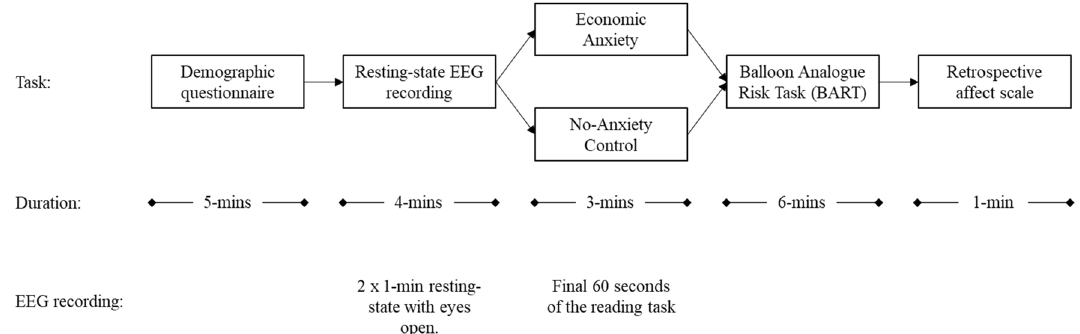
Figure 4. Flow chart of experimental procedure, duration of each task, and position of EEG doing well in the computerized Balloon Analogue Risk Task (BART 30 ). Participants pumped balloons across 20 trials, one balloon per trial, where each balloon had a variable and unknown pop-threshold. The average pop- threshold across trials was 15 pumps. Each pump slightly inflated the balloon and earned points but also brought the balloon closer to the pop-threshold. Popped balloons earned no points and participants could stop pumping at any time and collect the points earned on that trial. As in prior research using the BART, our primary measure of risk-taking was the average number of pumps on trials without explosions. We computed a second measure to tease apart strategic behavior and risk-taking—i.e., a coefficient of variability (COV). COV is computed here as the standard deviation across trials divided by average pumps across trials. Lower degrees of variability (i.e., lower COV scores) is thought to reflect more stringent adherence to a behavioral strategy and higher degrees of variability (i.e., higher COV scores) indicates more disinhibited decision-making. Consistent with the idea that COV indexes behavioral control, COV has been associated with greater executive function capacity in past research 57,58 . Finally, we computed a behavioral learning variable as total pumps on trials without explosions on the first five trials subtracted from total pumps on trials without explosions on the last five trials. We used the total score on non-explosion trials because the average score would not allow for people who learned to bank more points by avoiding explosion. For example, two participants could have the same average of 10 pumps, but one participant learned to avoid explosions and obtained 50 pumps in five trials, whereas the other participant did not learn to avoid explosions and obtained 20 pumps in two trials. Our variable thus captured this critical aspect of learning. Given that responding on the BART was generally risk-averse (i.e., almost all participants averaged below the optimal response of 15 pumps per trial), a higher score on this Learning score indicates that participants learned to approach optimal risk-taking. EEG recording and preprocessing. Continuous EEG was recorded using the 64 Ag–AgCl channel Acti- CHamp EEG system (Brain Products), positioned according to the 10/10 system and digitized at a sampling rate of 512 Hz (24 bit precision; bandwidth: 0.1–100 Hz). During recording, signals were referenced to TP9 electrode positioned over the left mastoid. Offline, EEG was re-referenced to the average mastoids (TP9-TP10), down-sampled to 256 Hz, band-pass filtered between 0.1 and 30 Hz, and notch filtered at 60 Hz. To ensure we examined anxiety-specific activation, EEG was segmented into the last 60 s of the economic anxiety manipula- tion. Blinks were statistically removed using an automatic ocular correction algorithm 66 . Artifacts were then automatically detected using the following parameters: − 100 to + 100 μV min/max threshold, 50 μV maximum voltage step, 0.5 μV lowest allowed voltage (maximum–minimum) in 100 ms intervals. Contiguous artefact-free epochs of 2 s were extracted through a hamming window and overlapped by 75% to avoid data loss. Power spec- tra were calculated via fast Fourier transform and power values (in μV 2 ) were averaged over all artefact-free and blink-free epochs. Absolute power was averaged for seven frequency bands 67 : delta (1.5–6 Hz), theta (6.5–8 Hz), the same preprocessing steps and calculated the absolute power values in the seven frequency bands. These data were used to control for baseline activation in our primary analyses.